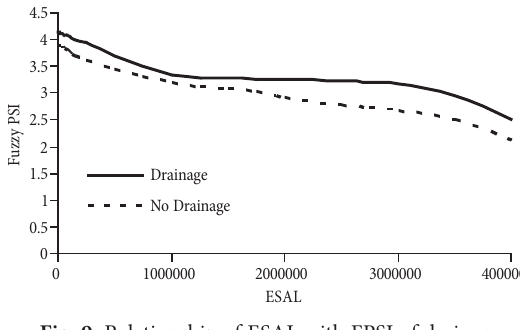
Fig. 9. Relationship of ESAL with FPSI of drainage